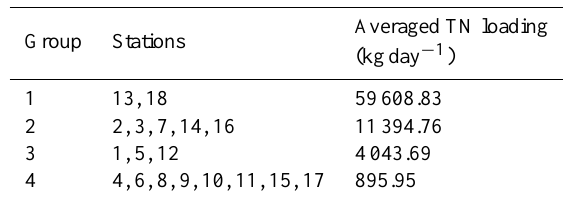
Table 5. Grouping of 18 selected stations based on k-means clus-